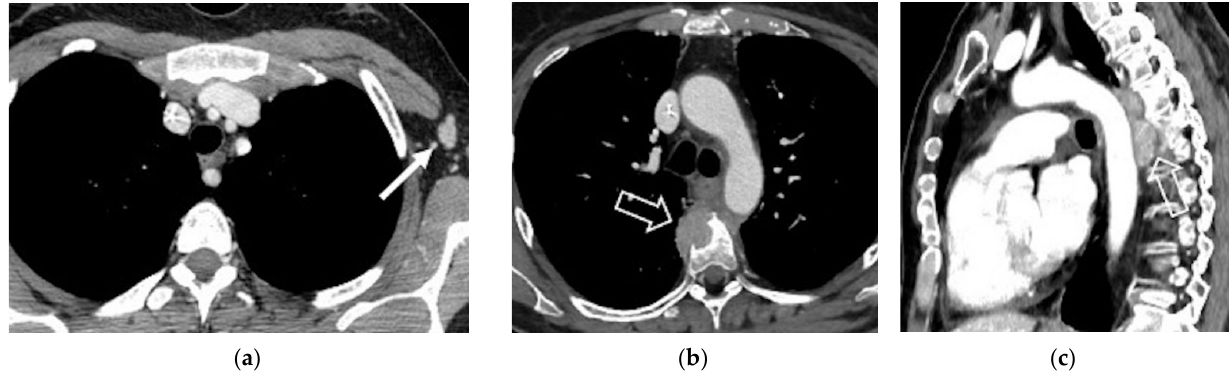
Figure 9. ( a ) A 40-year-old patient who underwent radical hysterectomy with BSO and chemoradiation therapy for cervical cancer. Axial post-contrast CT image shows left axillary lymph nodal relapse (solid arrow). ( b , c ) A 44-year-old patient who underwent radical hysterectomy with BSO and chemoradiation therapy for cervical cancer. ( b ) Axial and ( c ) sagittal post-contrast CT images show pathological mediastinal soft tissue infiltrating the vertebral soma (open arrows). A sensitivity of 85.7–100% and specificity of 86.7–100% have been reported for 18F- FDG PET/CT in detection of recurrent disease outside the pelvis in patients with prior gynecologic cancer [44].